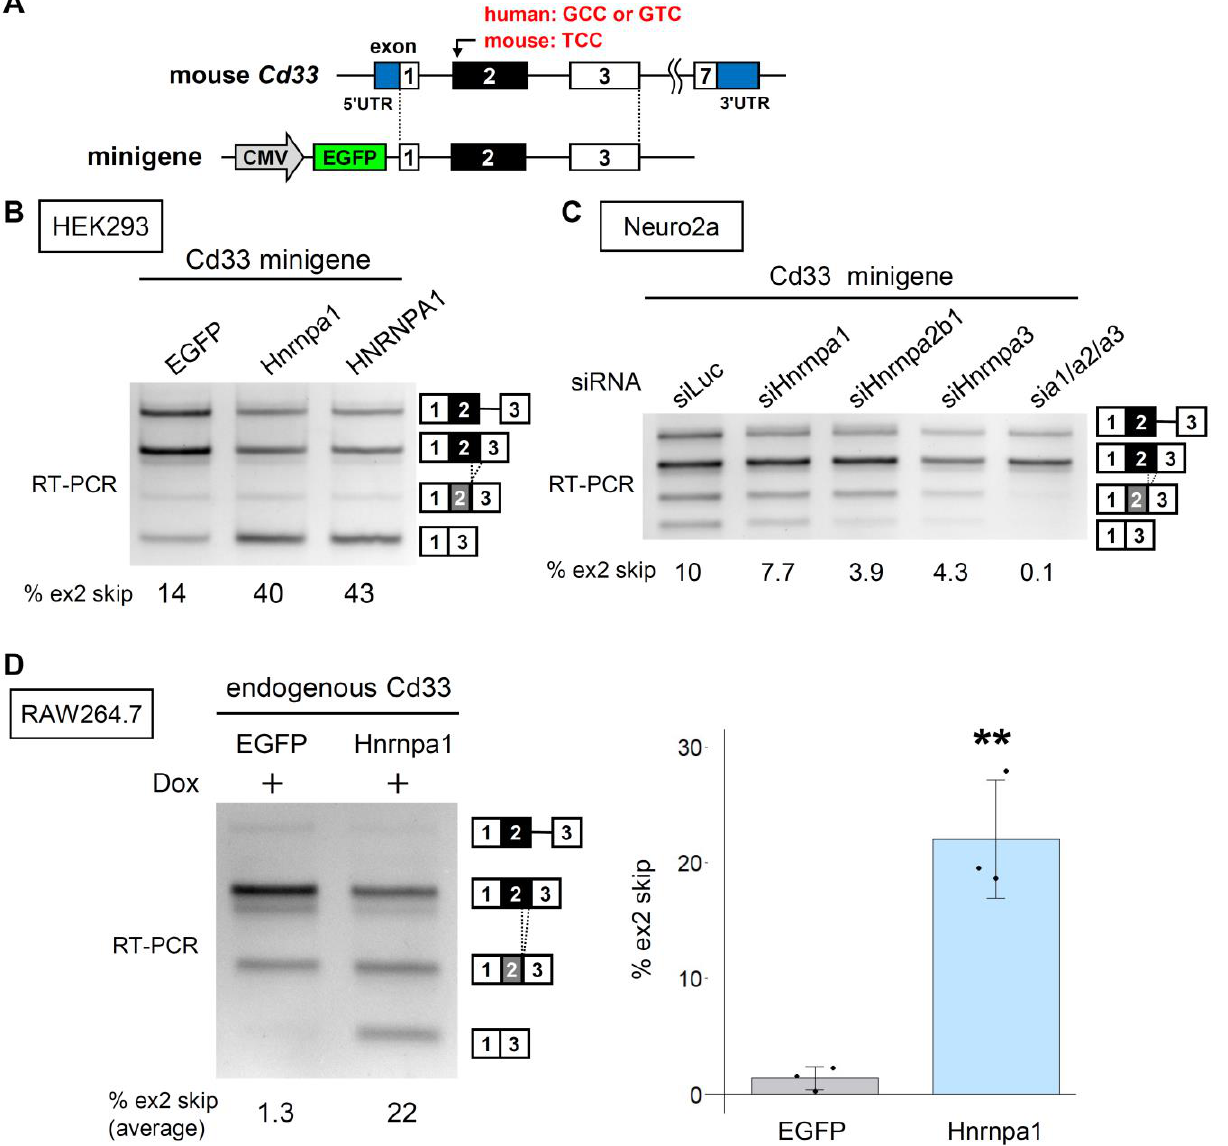
Figure 6. Splicing of mouse Cd33 is regulated by HNRNPA family proteins. ( A ) Schematic diagram of the mouse Cd33 minigene. The sequence of the codon overlapping with rs12459419 in human CD33 and the mouse counterpart are indicated in red. ( B ) Splicing assay of mouse Cd33 minigene in HEK293 cells. Quantification of exon 2 skipping (the lowest band) is shown at the bottom. ( C ) Splicing assay of mouse Cd33 minigene in Neuro2a cells treated with the indicated siRNA(s). Quantification is as in B. ( D ) Expression of EGFP or EGFP-Hnrnpa1 in RAW264.7 cell was induced with 1 µ g/mL doxycycline and assessed in the splicing assay. The bar chart shows the ratio of exon 2 skipping ( n = 3). Error bars represent SD. ** p = 0.0024 in a two- tailed Welch’s t -test.